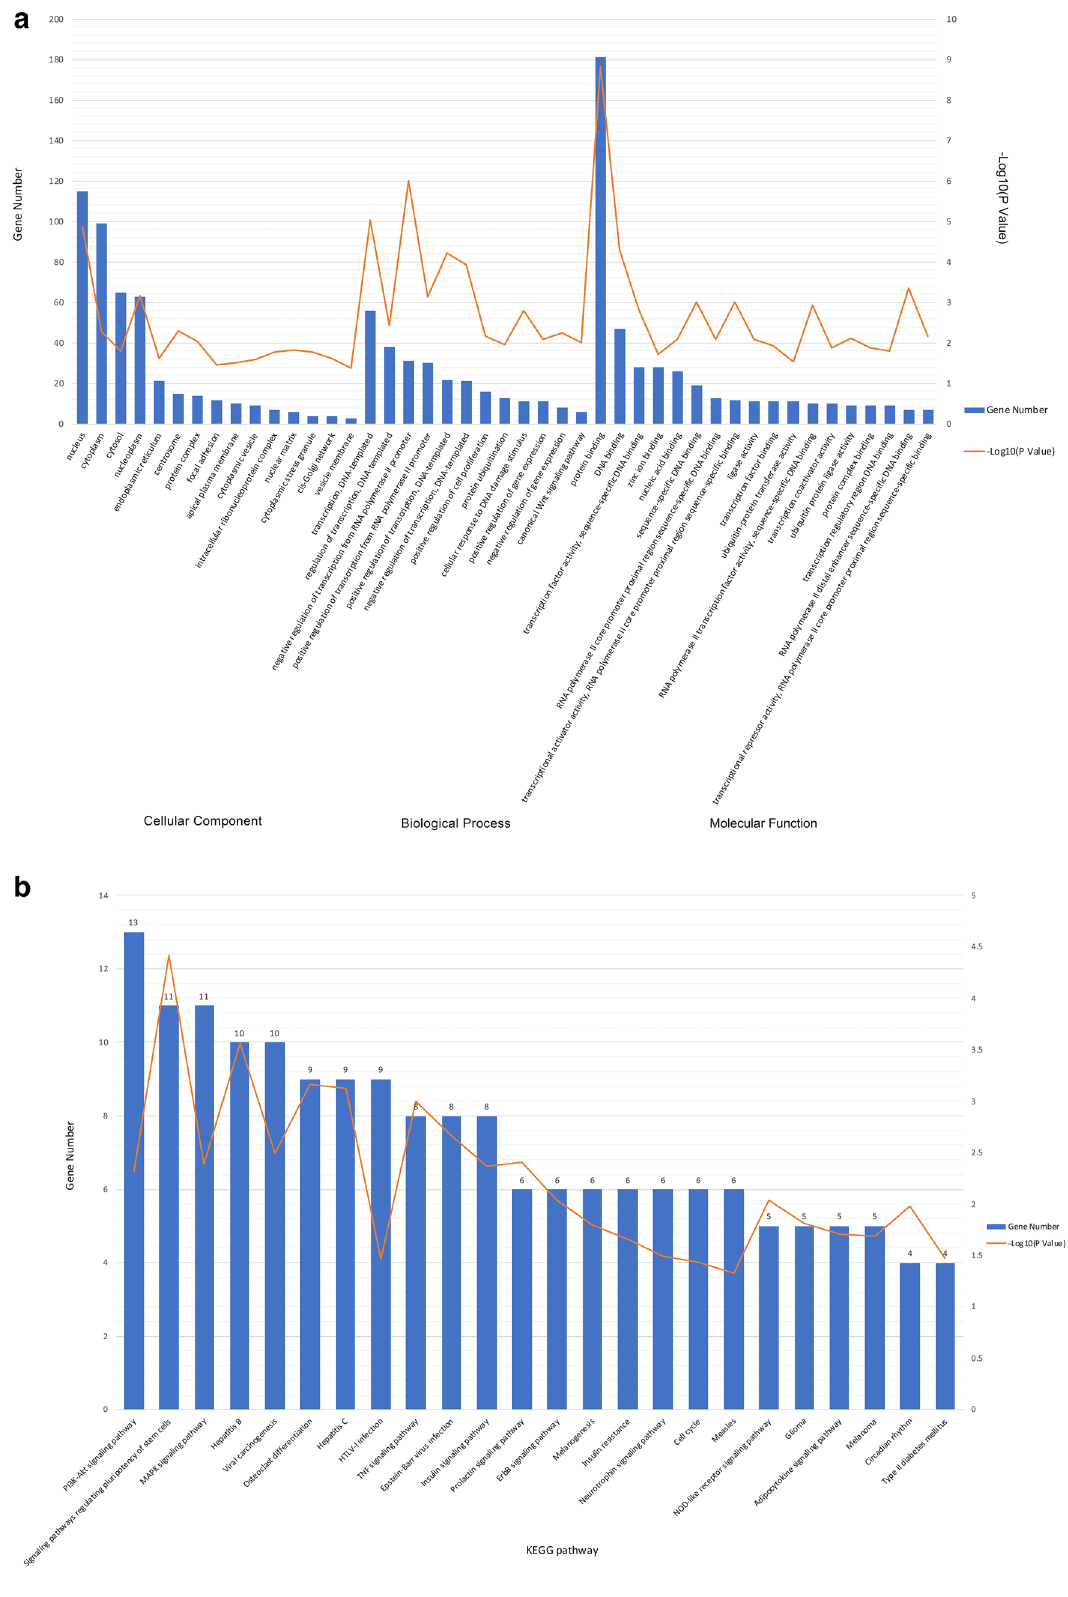
Figure 7. Functional analysis of circRNA. ( a ) Gene Ontology Analysis. ( b ) KEGG pathway Enrichment Analysis. The drawings were performed using Microsoft Excel (version 16.43, https:// www. micro soft. com/ zh- cn/ micro soft- 365/